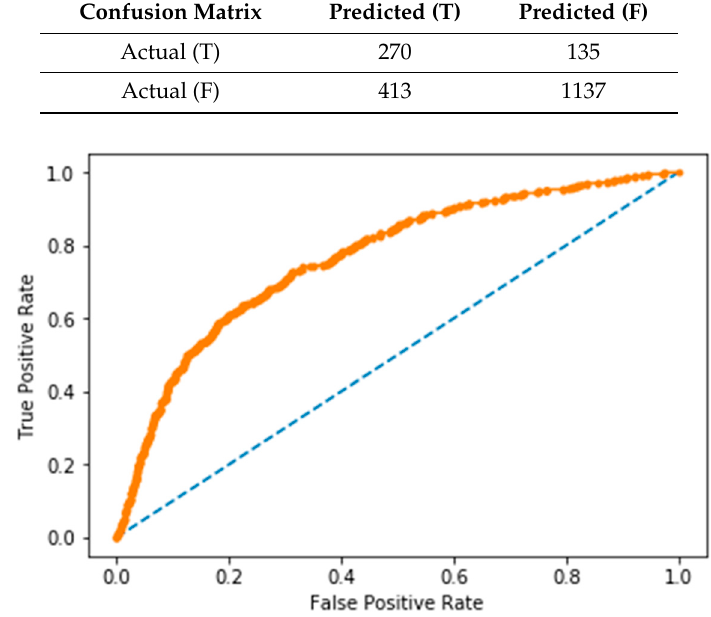
Figure 4. Receiver operating characteristic (ROC) curve for the predictive performance of DNN with scaled-PCA and area under the curve ( AUC ) of 76.8%.